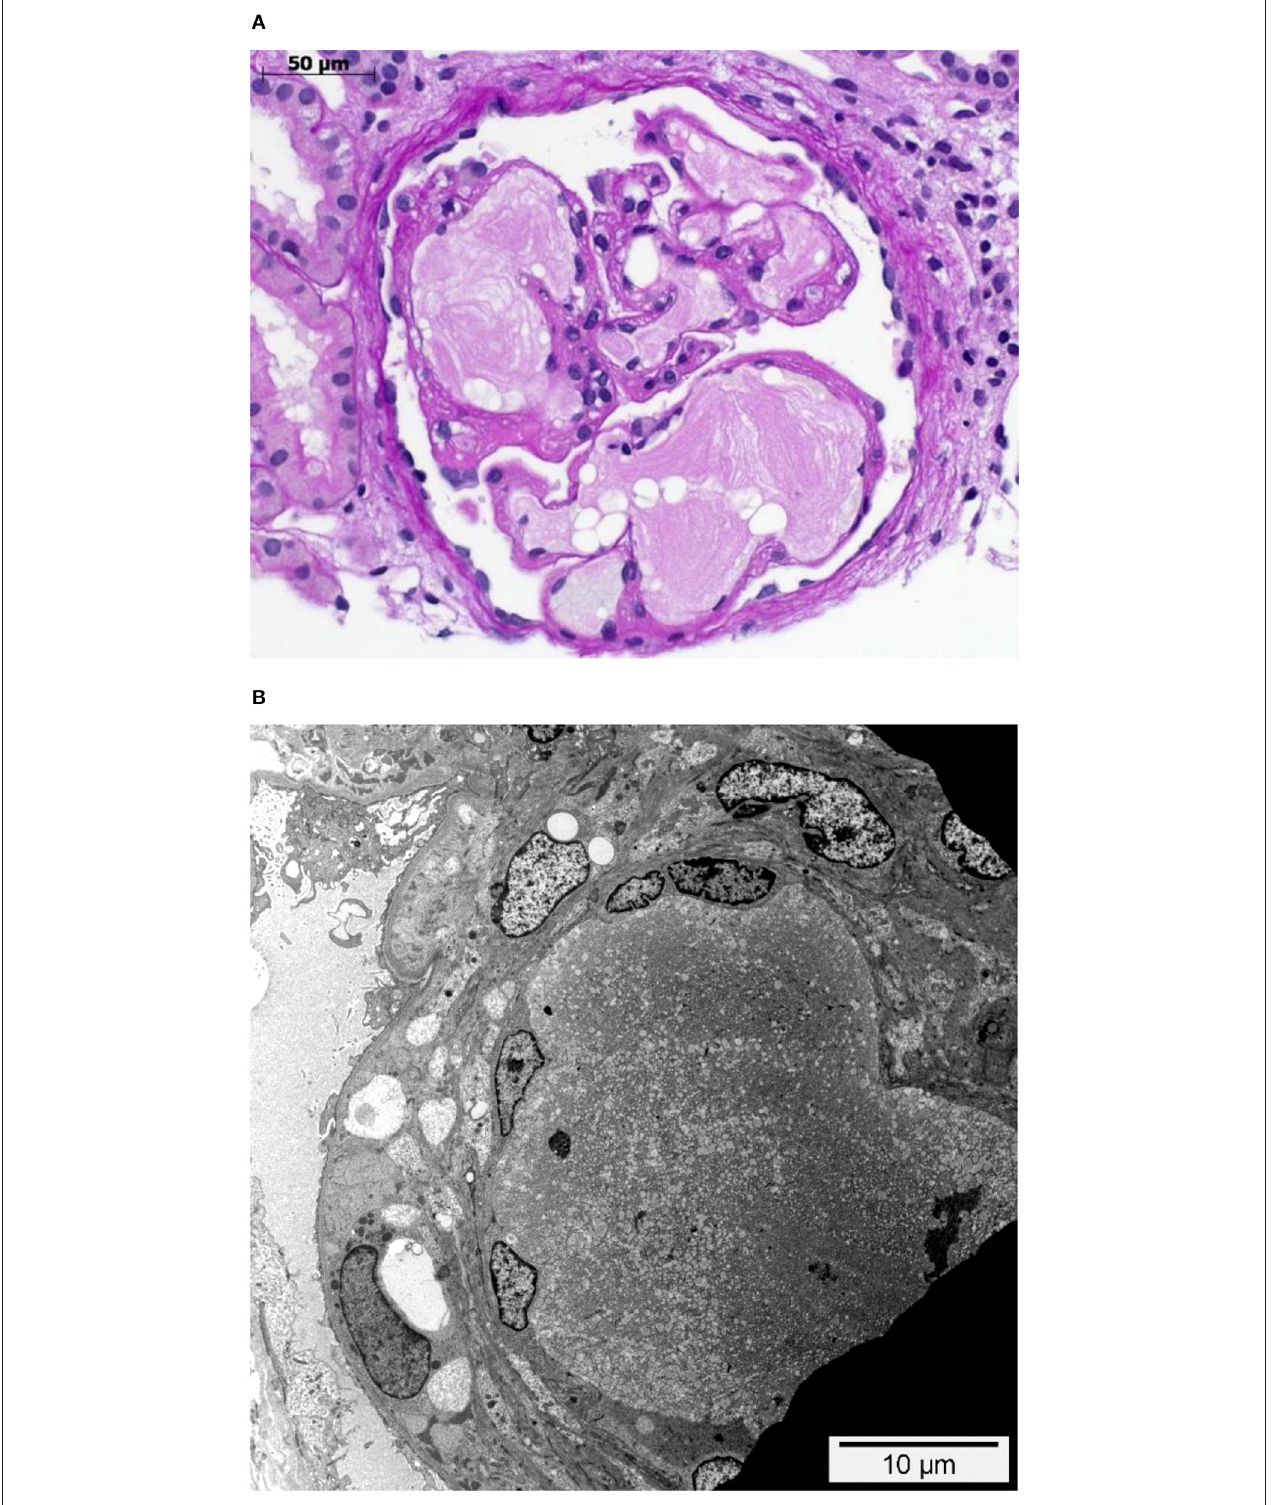
FIGURE 1 | Glomerulus with intraglomerular lipoprotein thrombi. (A) Glomerulus with dilated glomerular capillaries containing characteristic acellular, lamellated, intracapillary lipoprotein thrombi. PAS staining. (B) Dilated peripheral glomerular capillary containing a lipoprotein thrombus with its characteristic electron microscopic appearance. While the endothelial cells on the left-hand side are visible and slightly enlarged, they are not detectable in the upper right side. Transmission electron microscopy.